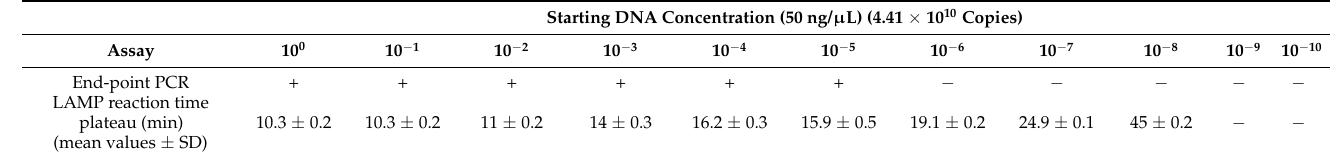
Table 4. Comparison of real-time LAMP and end-point PCR sensitivity.